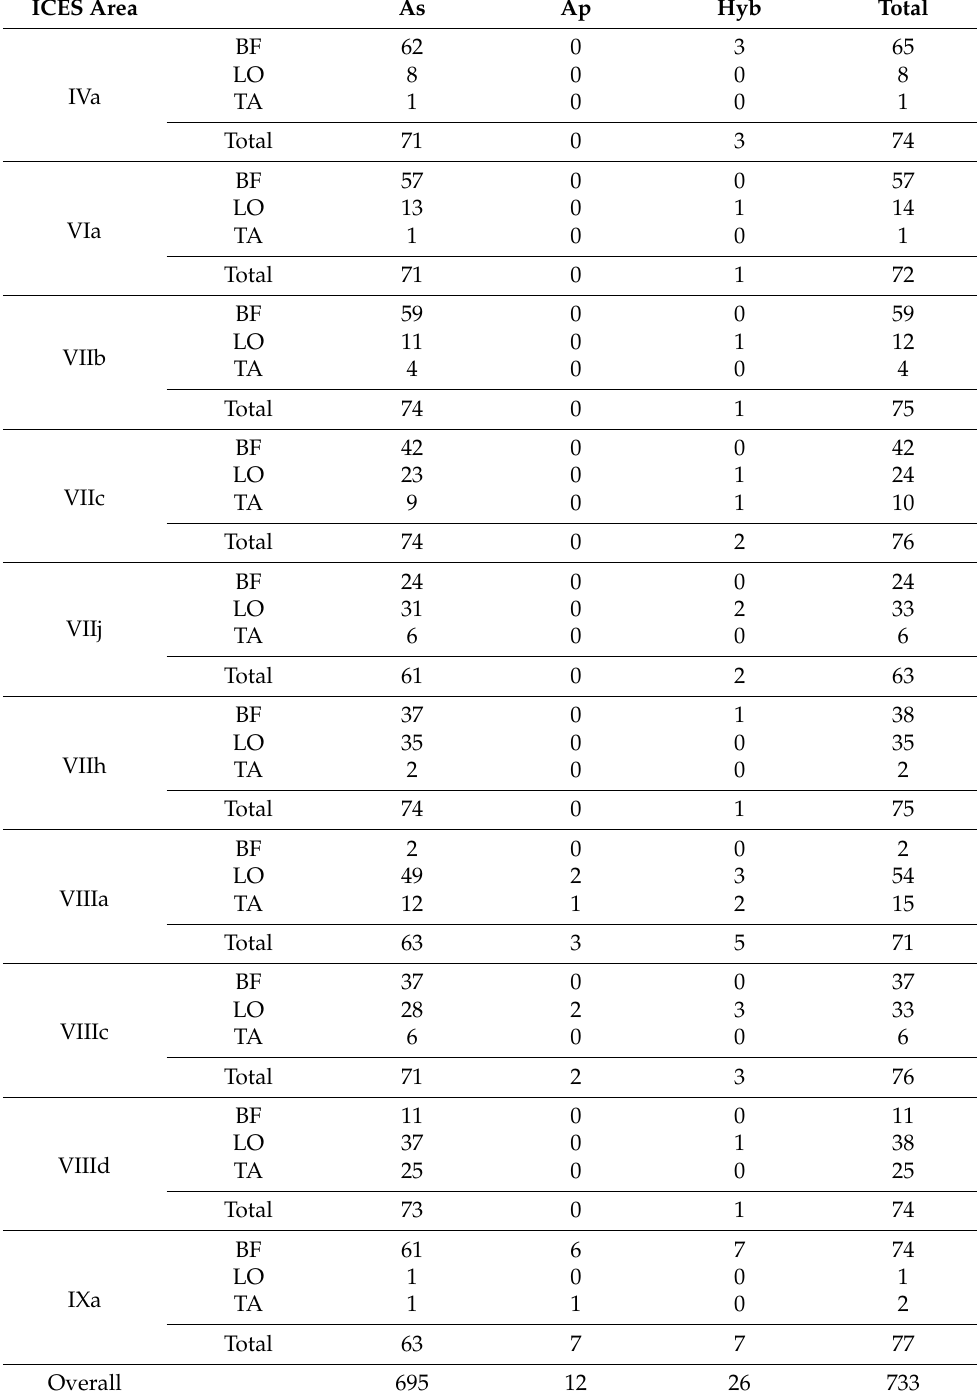
Table 1. Taxonomic identification of Anisakis larvae from muscular sections analyzed by sequencing of ITS